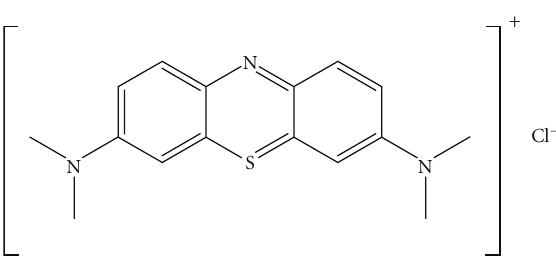
Figure 1: Structure of the methylene